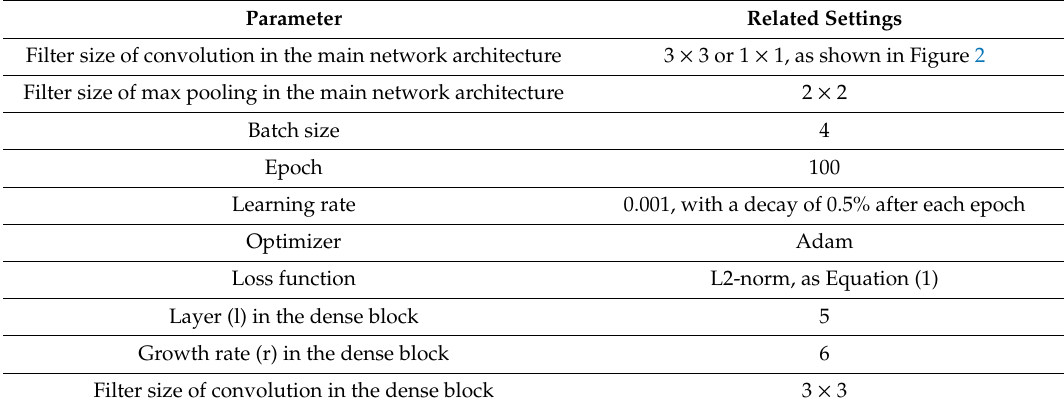
Table A1. Parameter settings of the proposed network.